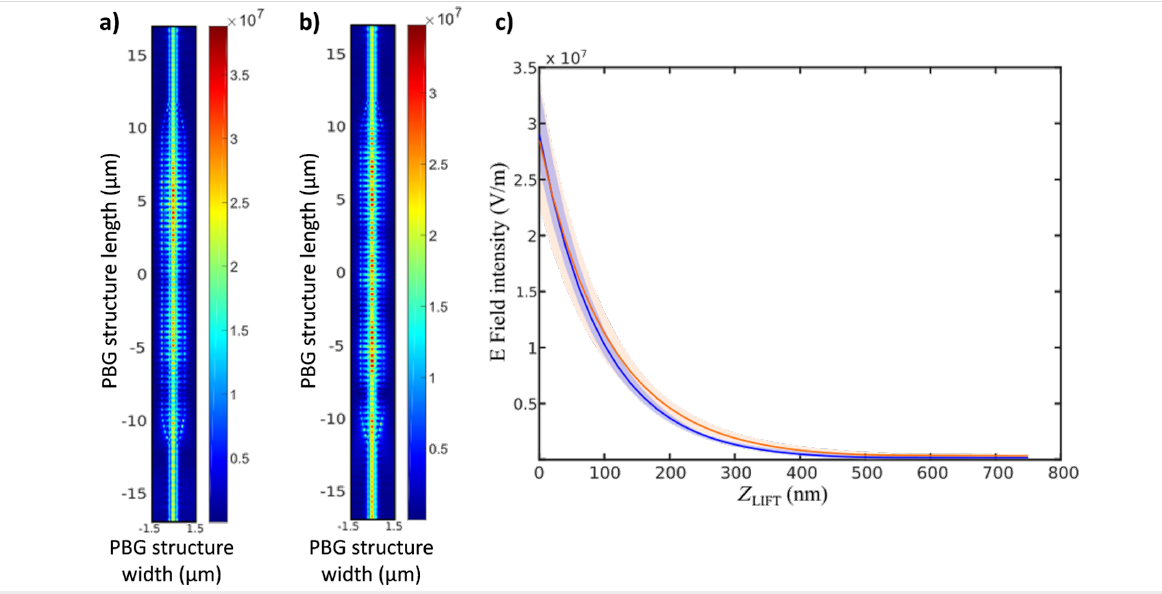
Figure 5: FDTD-simulated electric near-field intensity (V/m) through the PBG structure for (a) an upper cladding of air ( λ = 1550 nm) and (b) an upper cladding of water ( λ = 1600 nm). (c) Variation of the electric field intensity as a function of the distance to the sensor surface for the FDTD simulations when considering an air (blue) and a water upper cladding (red). As for Figure 4, the shaded areas represent the standard deviation of the intensity along the PBG